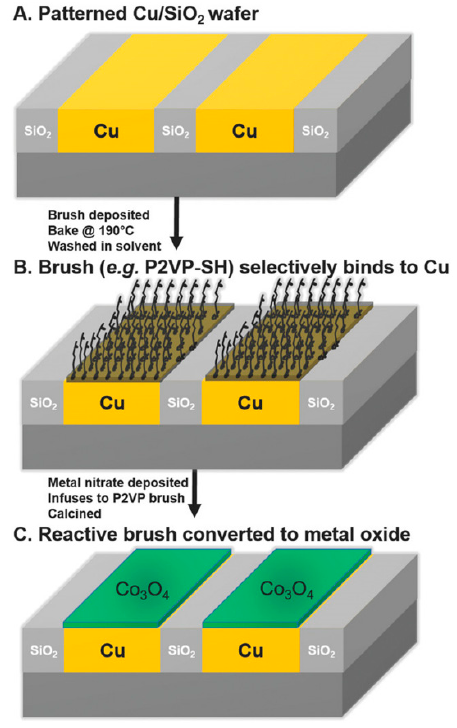
Figure 2. An example of ASD of P2VP-SH brush onto a Cu/SiO 2 wafer and subsequent metal oxide patterning [7]. Image reproduced with permission from Wiley [7].